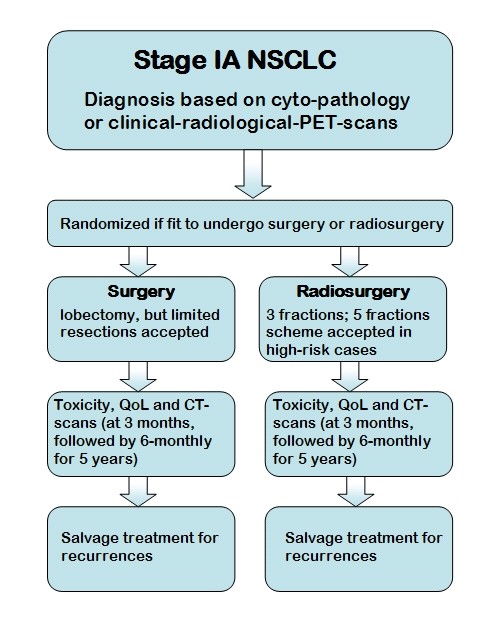
ROSEL study design.